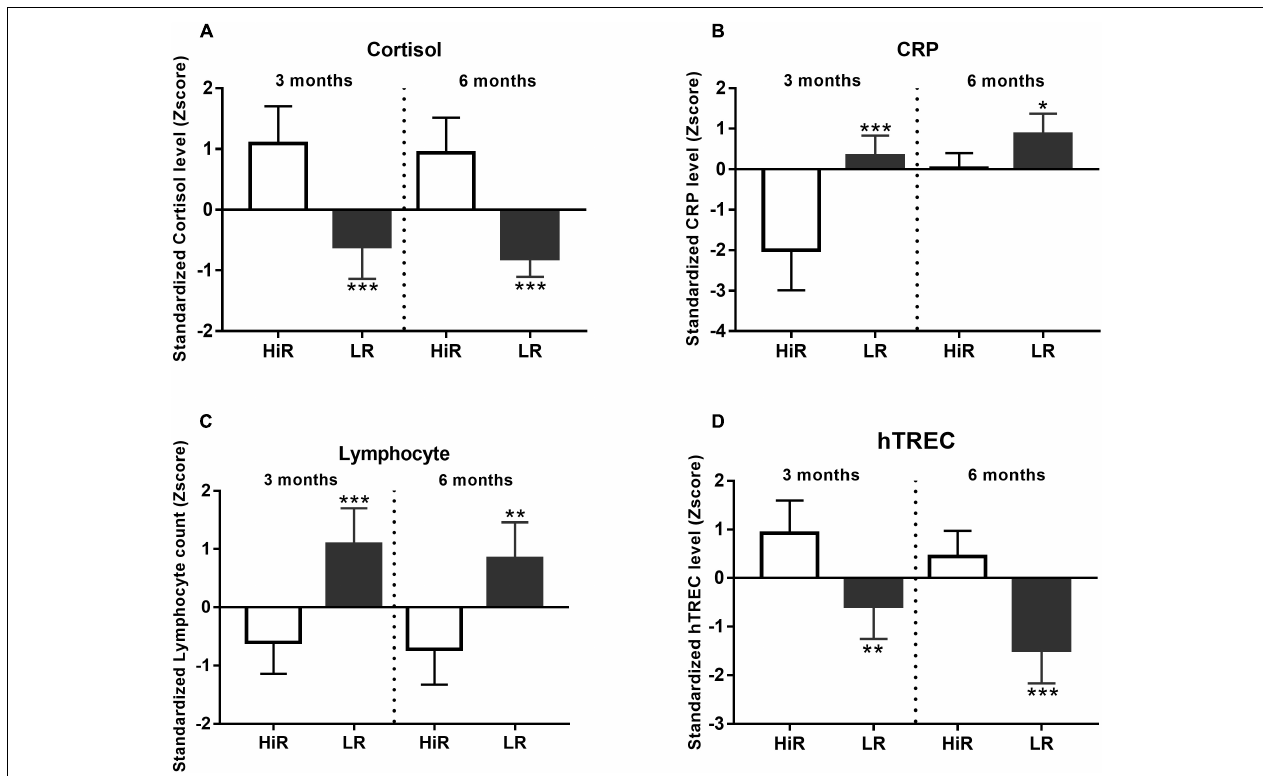
FIGURE 3 | Individual variation of immunological parameters in response to lifestyle program. (A–D) K-means cluster analysis was used to differentiate high- (HR) and low (LR) responders ( n = 14). Bar graph values indicate standardized Z-score values, and standard deviation values. 3- and 6-month values were normalized to baseline values and converted to Z-scores. ∗ Significant difference between HR and LR ( p < 0.05). ∗∗ Significant difference between HR and LR ( p < 0.01). ∗∗∗ Significant difference between HR and LR ( p < 0.001). Please refer to Supplementary Material S1 for exact numerical values.